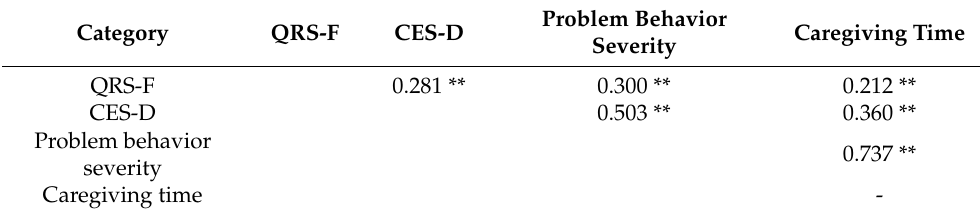
Table 4. Correlation between